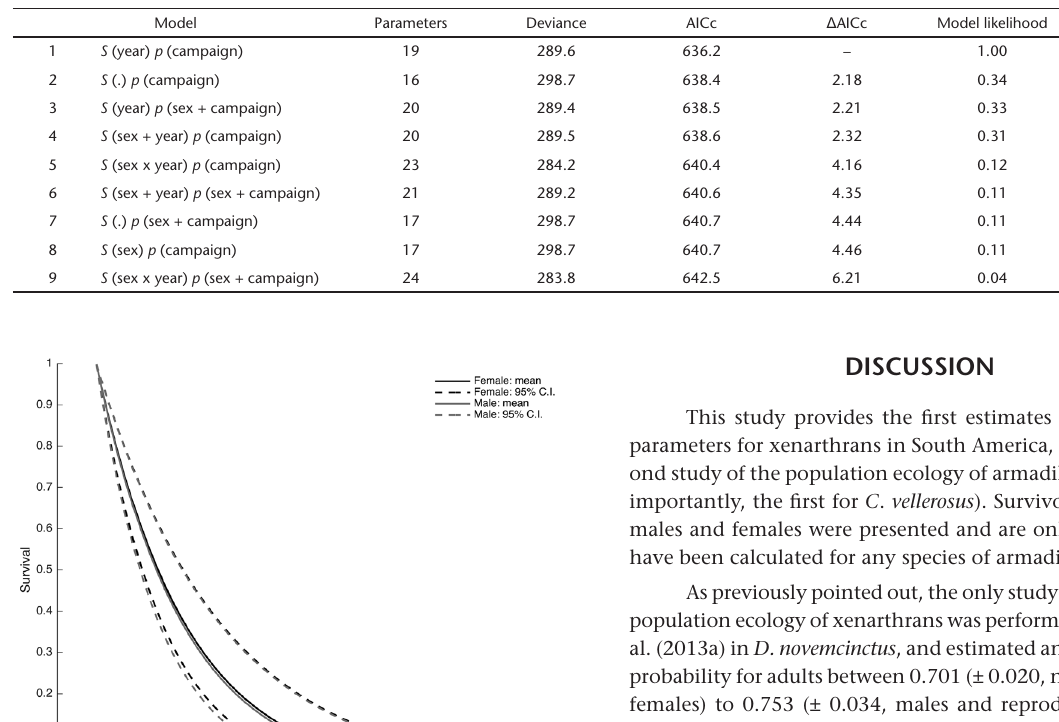
Table 2. CJS models fitted to the capture-recapture data of Chaetophractus vellerosus , ranked according to the Akaike information criteri- on. Note that only the top 9 out of 25 candidate models are presented, which collectively accounted for >0.99 of the cumulative Akaike weight. Model structure is indicated by listing between parentheses which variables affect survival rates ( S ) and capture probability ( p ), using a single point (.) when no variable has an effect.